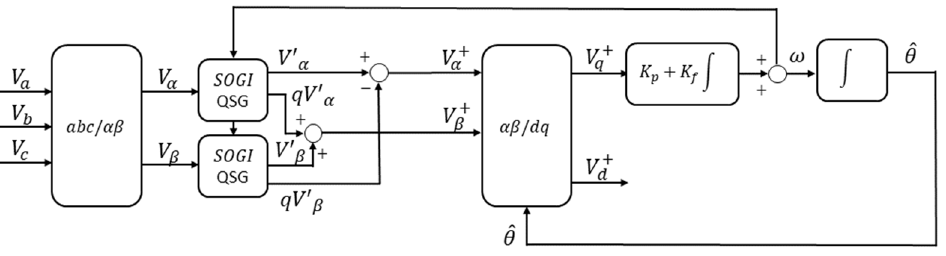
Figure 8. Diagram of the DSOGI-PLL.